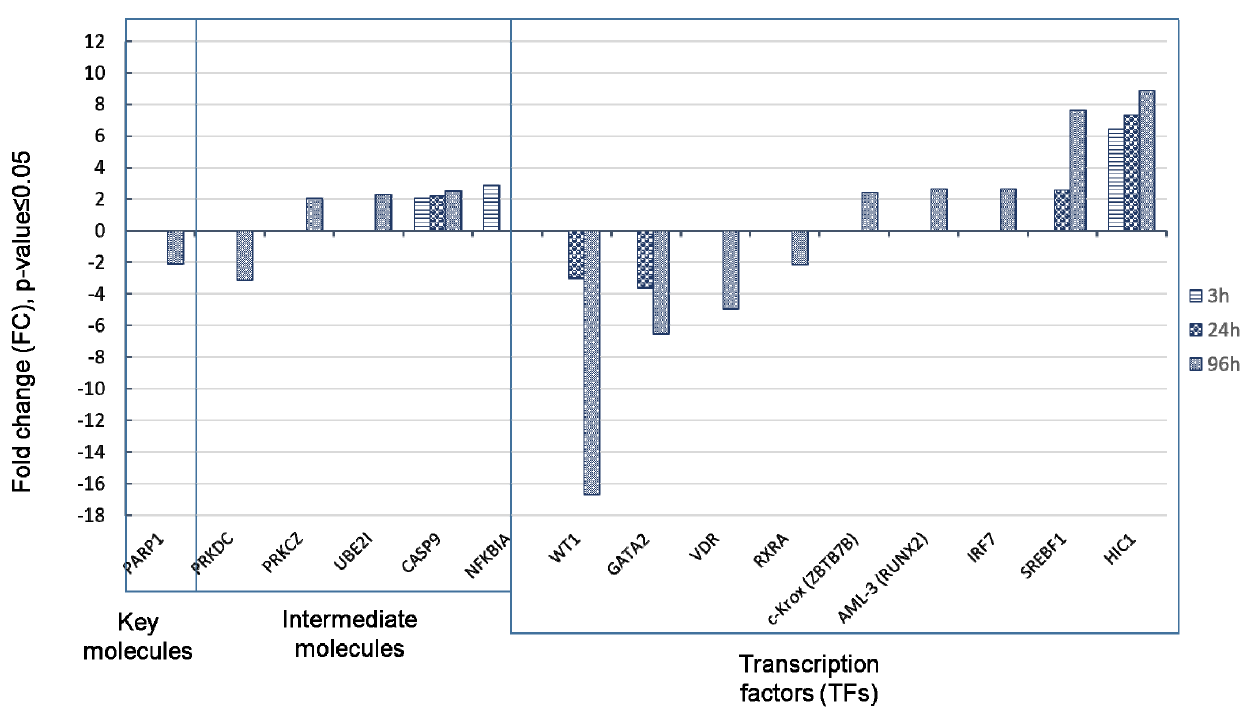
Figure 6. Components of transcriptome- and proteome-based model networks with altered mRNA expression under ATRA treatment. Transcription factors, TFs (predicted by TRANSFAC@ database), intermediate and key molecules (predicted by TRANSPATH@ database) with fold change ≥ 2 ( p -value ≤ 0.05) at 3, 24, and 96 h is presented.